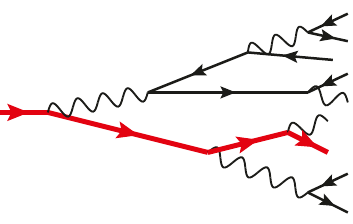
Figure 10 . The red (heavy) line above shows an example of following an initial fermion through a shower to see where it is deposited. When the NLO e(cid:11)ect of overlapping formation times is considered, this picture is only valid in certain theories like large- N f QED (see text).